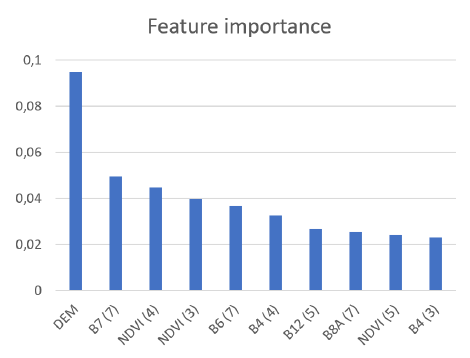
Figure 7. Spain: Feature importance (top 10).